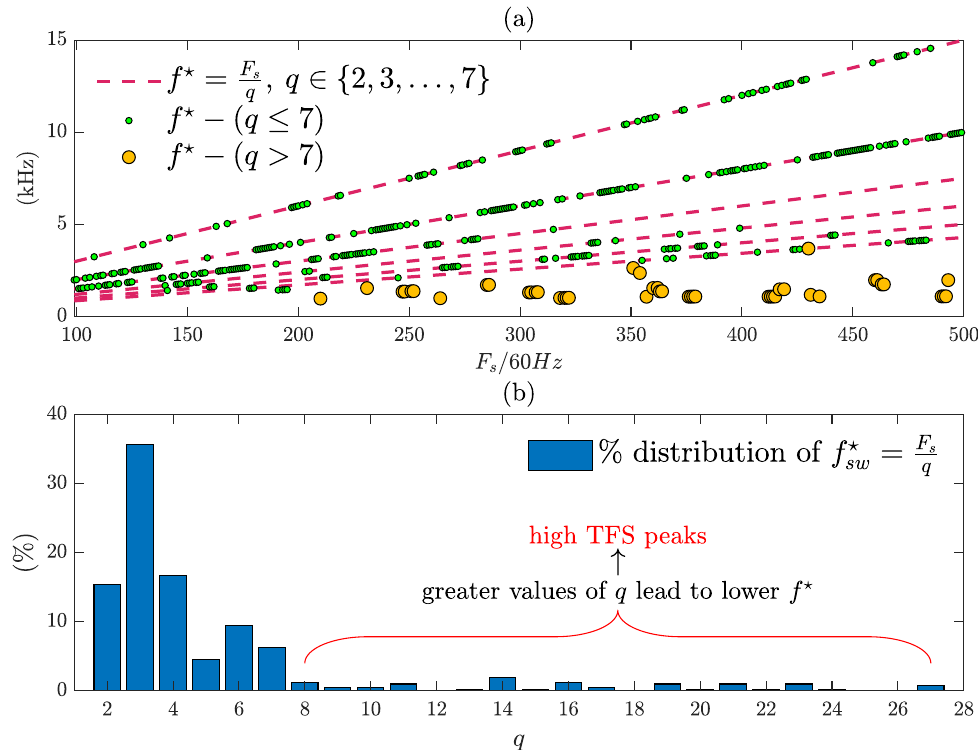
Figure 13. Effect of sampling frequency in FCS-MPC: ( a ) f (cid:63) sw as an integer ratio of F s (see Equation (13)), for different values of q ; ( b ) percent distribution of q —high TFS peaks are associated with high values of q